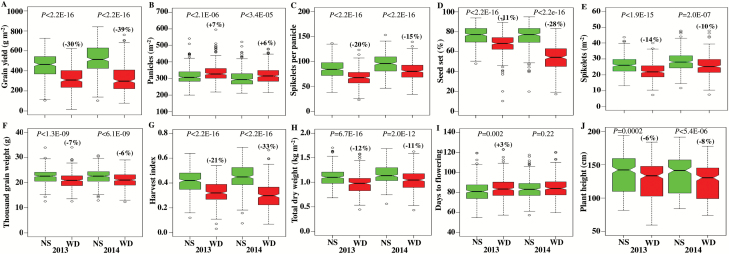
Box-plot showing phenotypic distribution of grain yield and its components and related traits in non-stress (NS) and water-deficit stress (WD) during 2013 (n=271) and 2014 (n=268). Two-sample t-test P-value shows the significant difference between grain yield (A), its components (B–F), and related traits (G–J) in NS and WD conditions. n, number of genotypes. Inside boxplot, the bold line represents the median, box edges represent upper and lower quantiles, and whiskers are 1.5× the quantile of the data. Outliers are shown as open circles. Values in parentheses represent the significant percentage change (increase (+) or decrease (−)) in WD over NS conditions. Days to maturity across treatments in 2013 and data for non-grain tissue dry weight across treatments and years are given in Supplementary Table 1. The values of phenotypic traits given in the box-plot under 2013 water deficit are the original, not corrected for days to flowering to account variation in flowering synchronization.